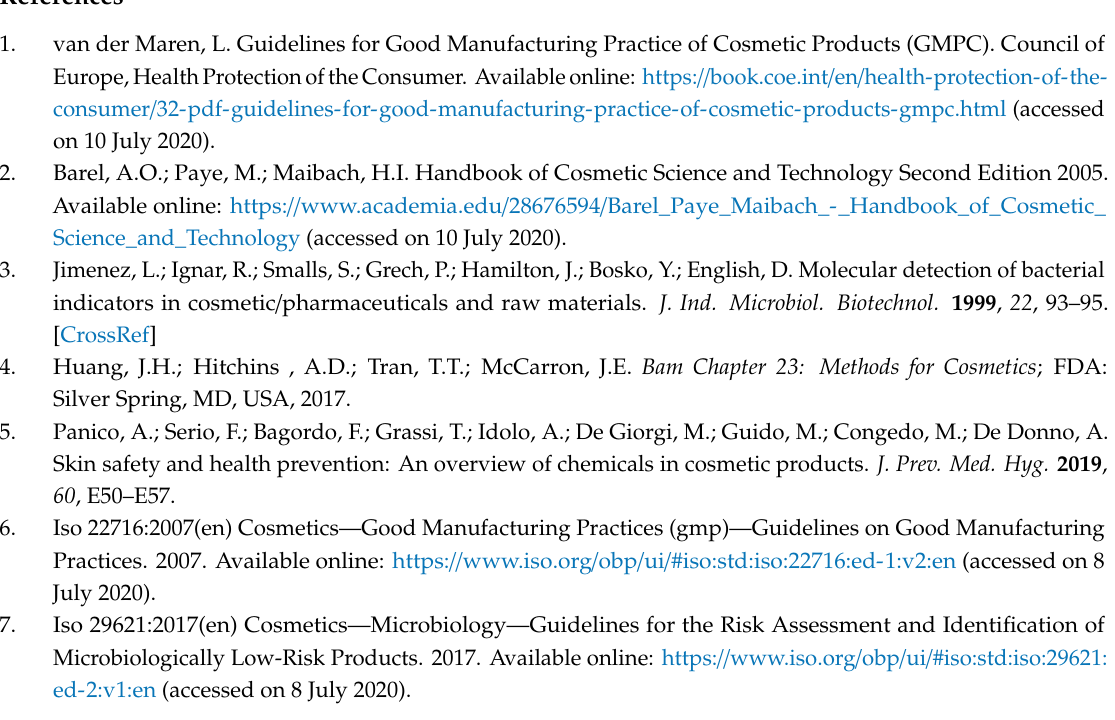
Supplementary Table S1: raw data of spectrophotometer measurements of absorbance at 260 nm (A260), at 280 nm (A280), A260 / A280 and A260 / A230